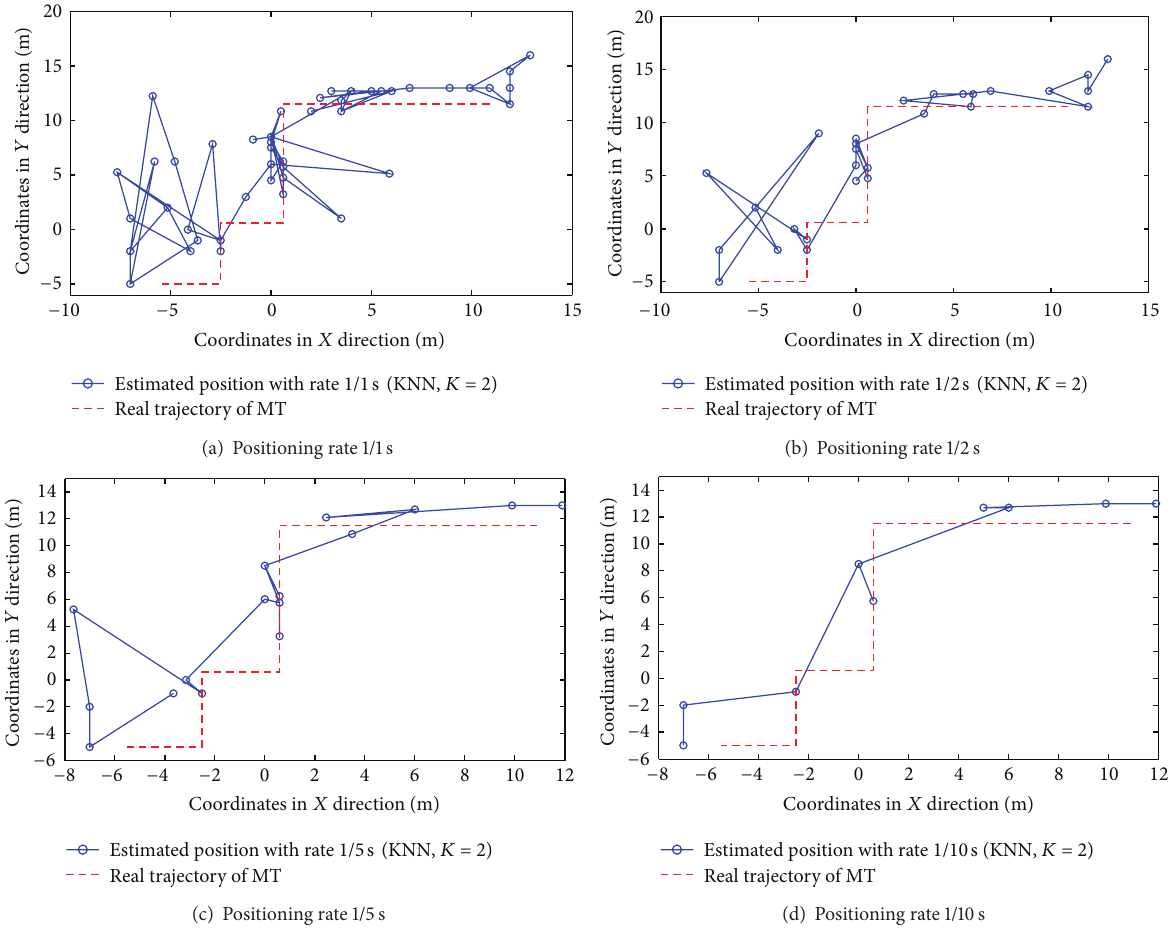
Figure 15: Results of dynamic positioning by KNN with 𝐾 = 2